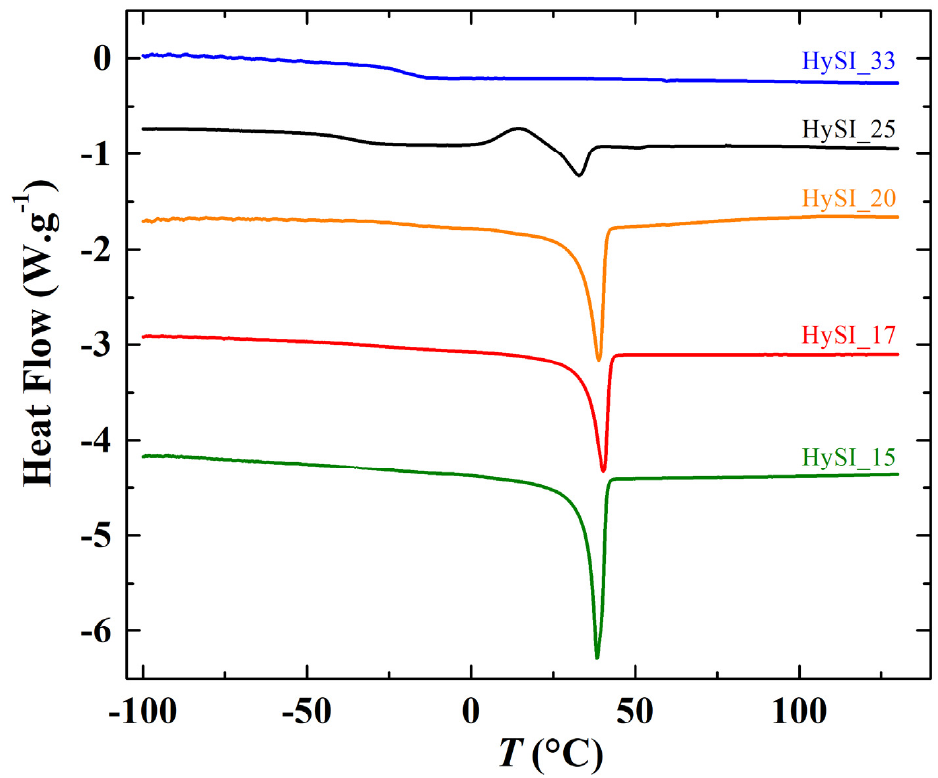
− 100 ◦ C to 125 ◦ C at 10 ◦ C · min − 1 of the HySI Figure 3. Thermograms from − 100 °C to 125 °C at 10 °C.min − 1 of the HySI electrolytes. Figure 3. Thermograms from